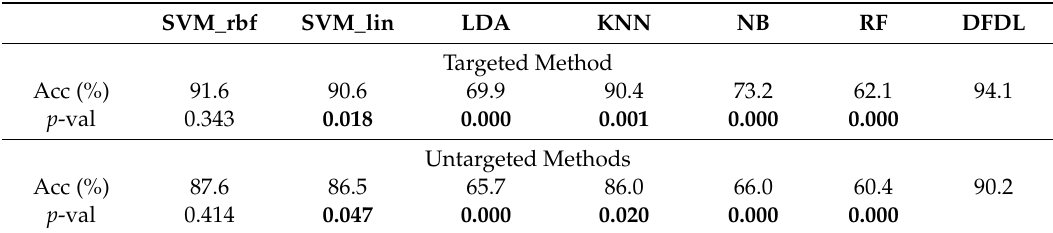
Table 1. Average Classification Accuracies for Healthy